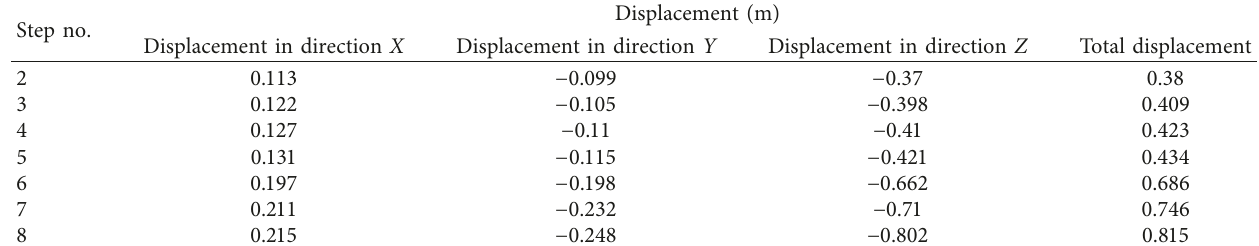
Table 10: Maximum displacement (absolute value) of each step in numerical simulation.